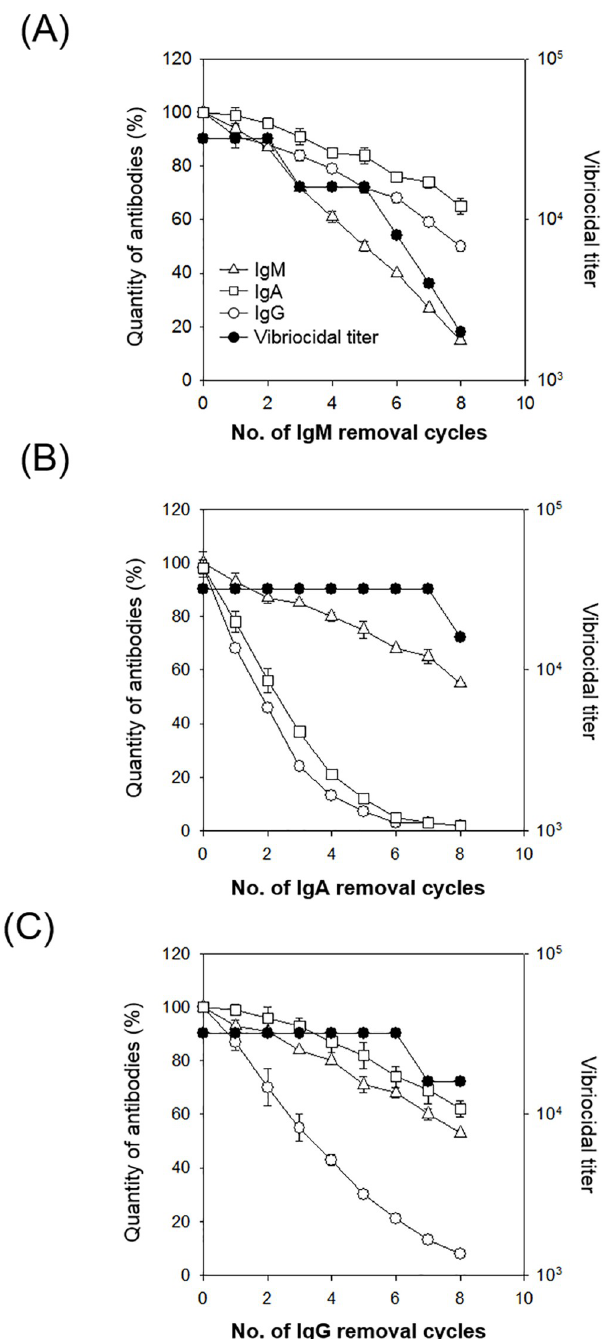
Fig 2. Vibriocidal activities were significantly decreased by depletion of IgM in serum. Pooled convalescent sera were incubated with anti-human IgM, anti-human IgA-bound protein G-agarose, or protein G-agarose to remove IgM (A), IgA (B), and IgG (C), respectively. The levels of antibody isotypes ( Δ , IgM; □ , IgA; � , IgG) were determined using ELSIA and were compared with their vibriocidal activity ( ● ) in the supernatant. Values are shown mean ± standard deviation of triplicate